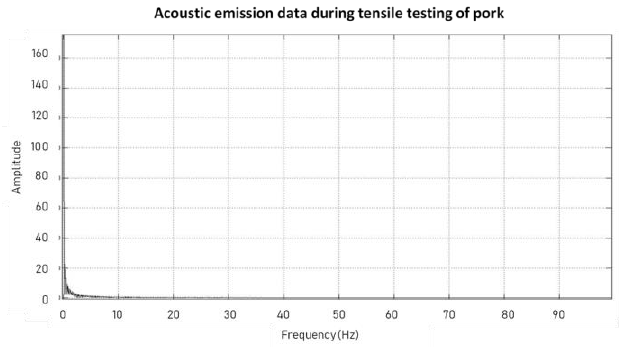
Figure 10. Plot of amplitude against frequency for pork specimen showing no discernible change in frequency of the recorded